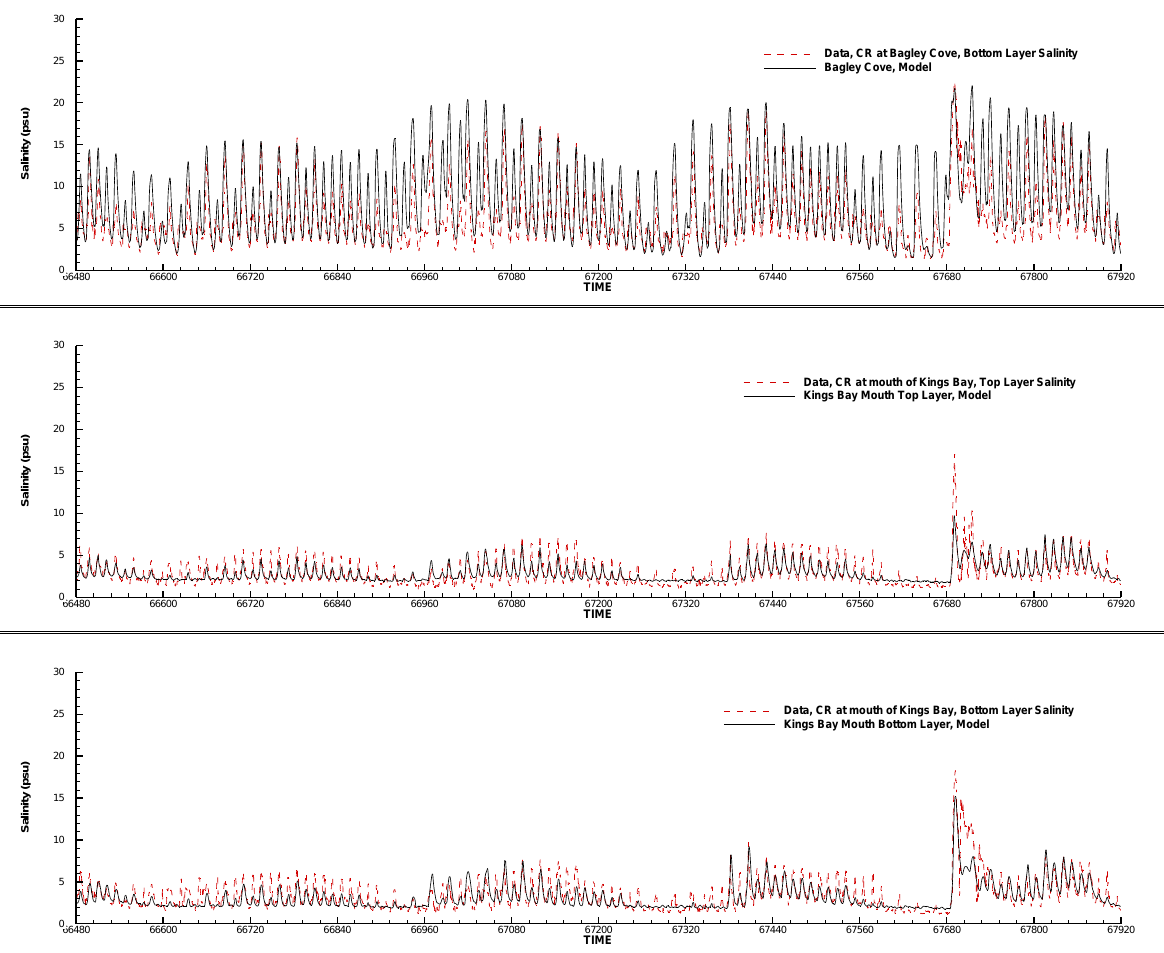
two measurement stations. The top panel of the figure is for the Bagley Cove station, and the bottom panel is for the mouth of Kings Bay station. Dashed lines are measured water level data, while solid lines are simulated water level results by the UnLESS3D model. Figure 8 shows and compares simulated and measured salinities. The top panel is for the bottom layer at the Bagley Cove station (salinity and temperature were only measured near the bottom at this station), while the middle and bottom panels are for the top and bottom layers, respectively at the mouth of Kings Bay station. Again, dashed lines are measured field data and solid lines are model results. In Figure 9, simulated and measured temperatures at Bagley Cove and the mouth of Kings Bay are shown and compared in the same manner as that in Figure 8, with dashed lines being field data and solid lines being model results. Figure 8. Comparison of measured and simulated salinities near the bottom at the Bagley Cove station (top panel), in the top layer at the mouth of King Bay station (middle panel), and in the bottom layer at the mouth of Kings Bay station (bottom panel) during 2 August–1 October 2007.